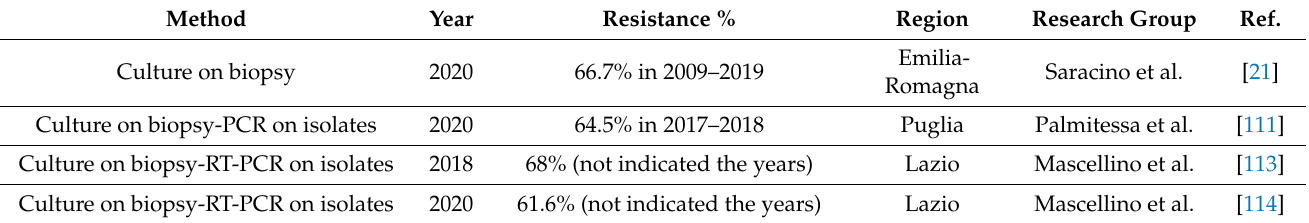
Table 7. Secondary metronidazole resistance in